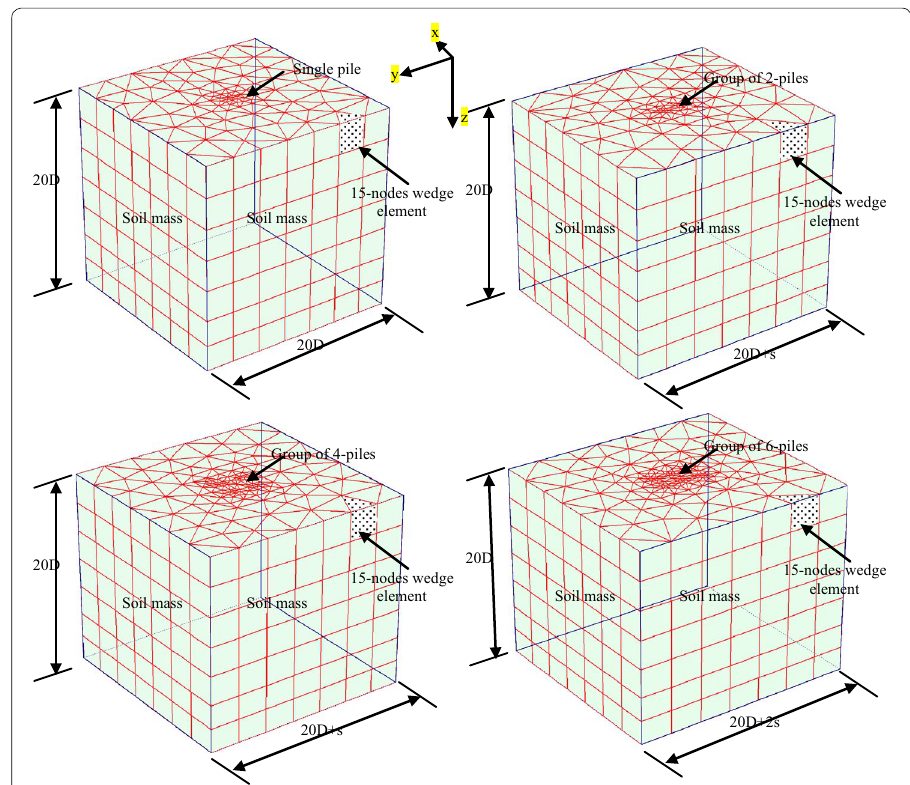
Fig. 3 Three‑dimensional view of the finite element mesh of the single pile and 2, 4 and 6‑pile groups and surrounding soil